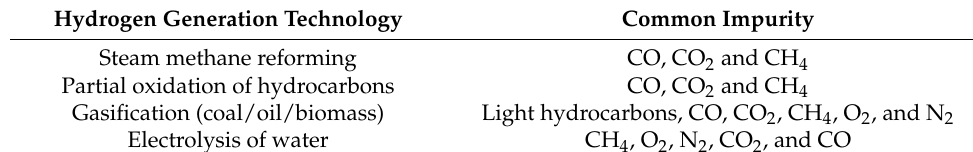
Table 1. Hydrogen from different generation technologies and its common impurities [33] .